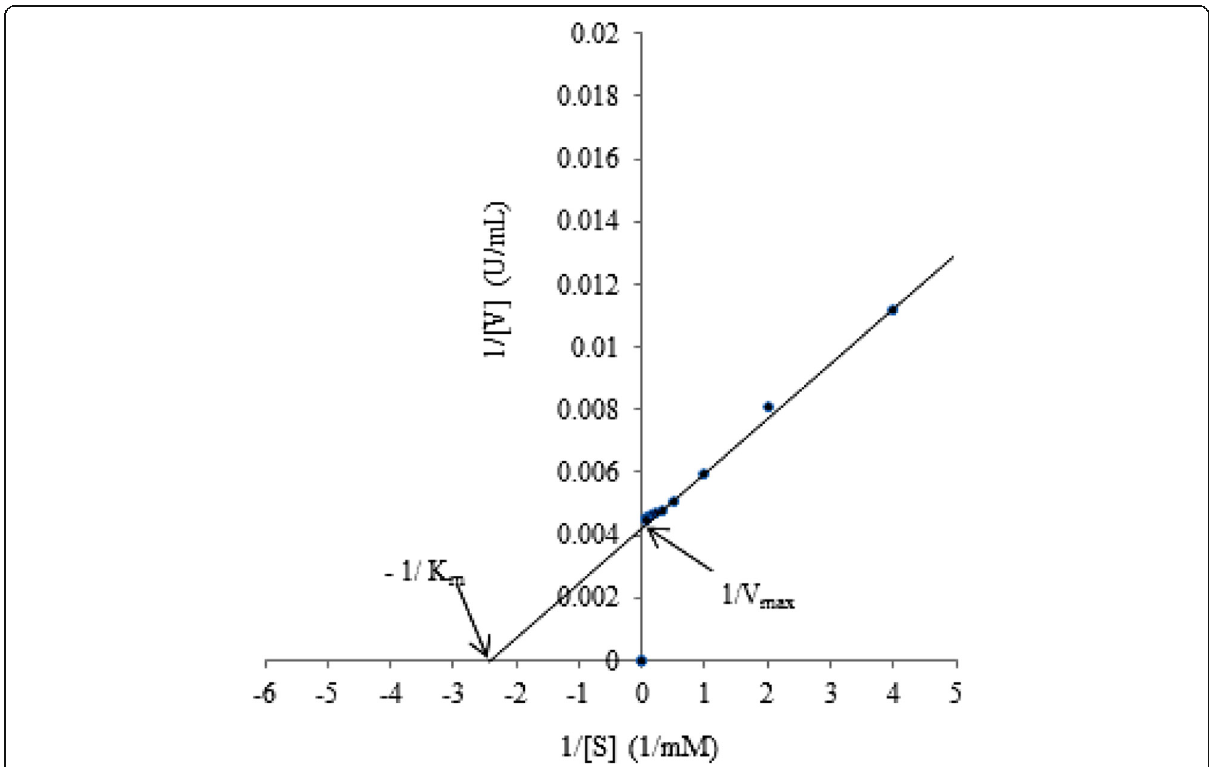
Fig. 6 Lineweaver-Burk plot stating hydrolysis rate of different concentrations of p -NPG by Aspergillus sp. DHE7 β -glucosidase. Enzyme activity was calculated at 60 °C in 50 mM Na-citrate buffer pH 6.0. The values of K m and V max of β -glucosidase were 0.4 mM and 232.6,